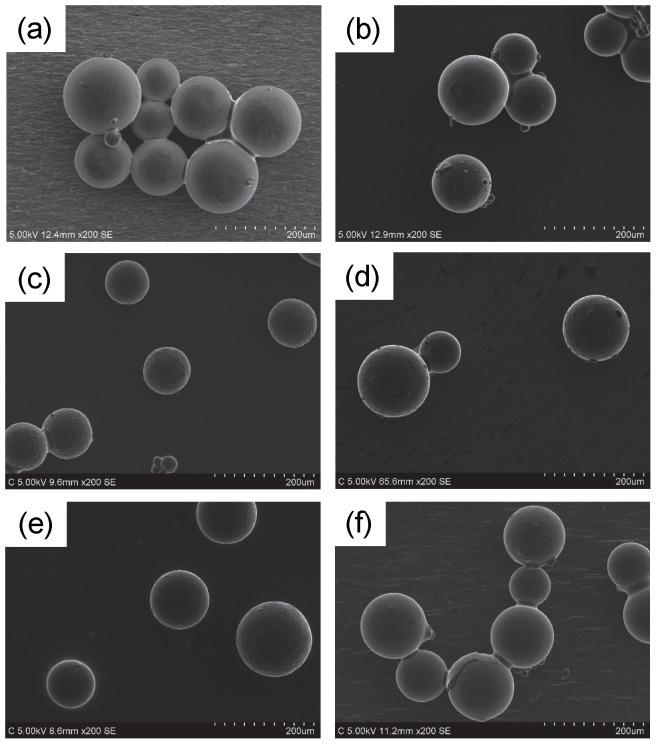
SEM images of original dry SAP particles pretreated with different neat RTILs.(a) [C2mim][BF4]; (b) [C2mim][AcO]; (c) [C2mim][Lac]; (d) [C4mim][BF4]; (e) [Ch][Lac]; (f) [P4, 4, 4, 1][DMP].